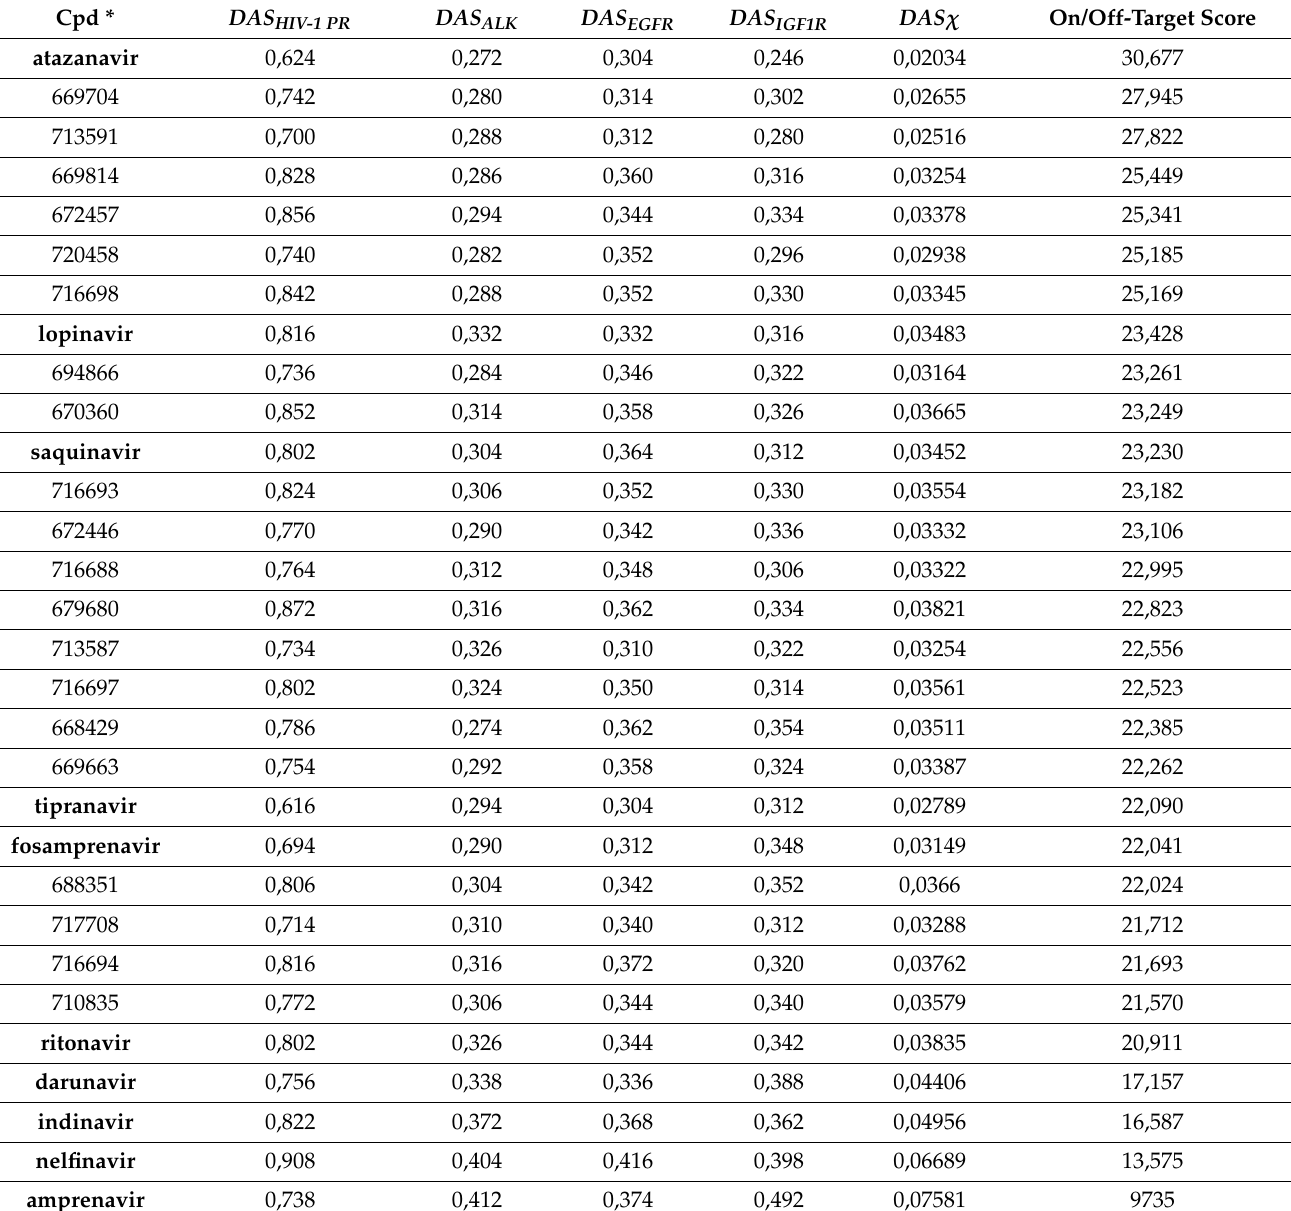
Table 1. DAS data and the on/off-target scores for the twenty top-scored structures and the 10 FDA-approved HIV-1 PR